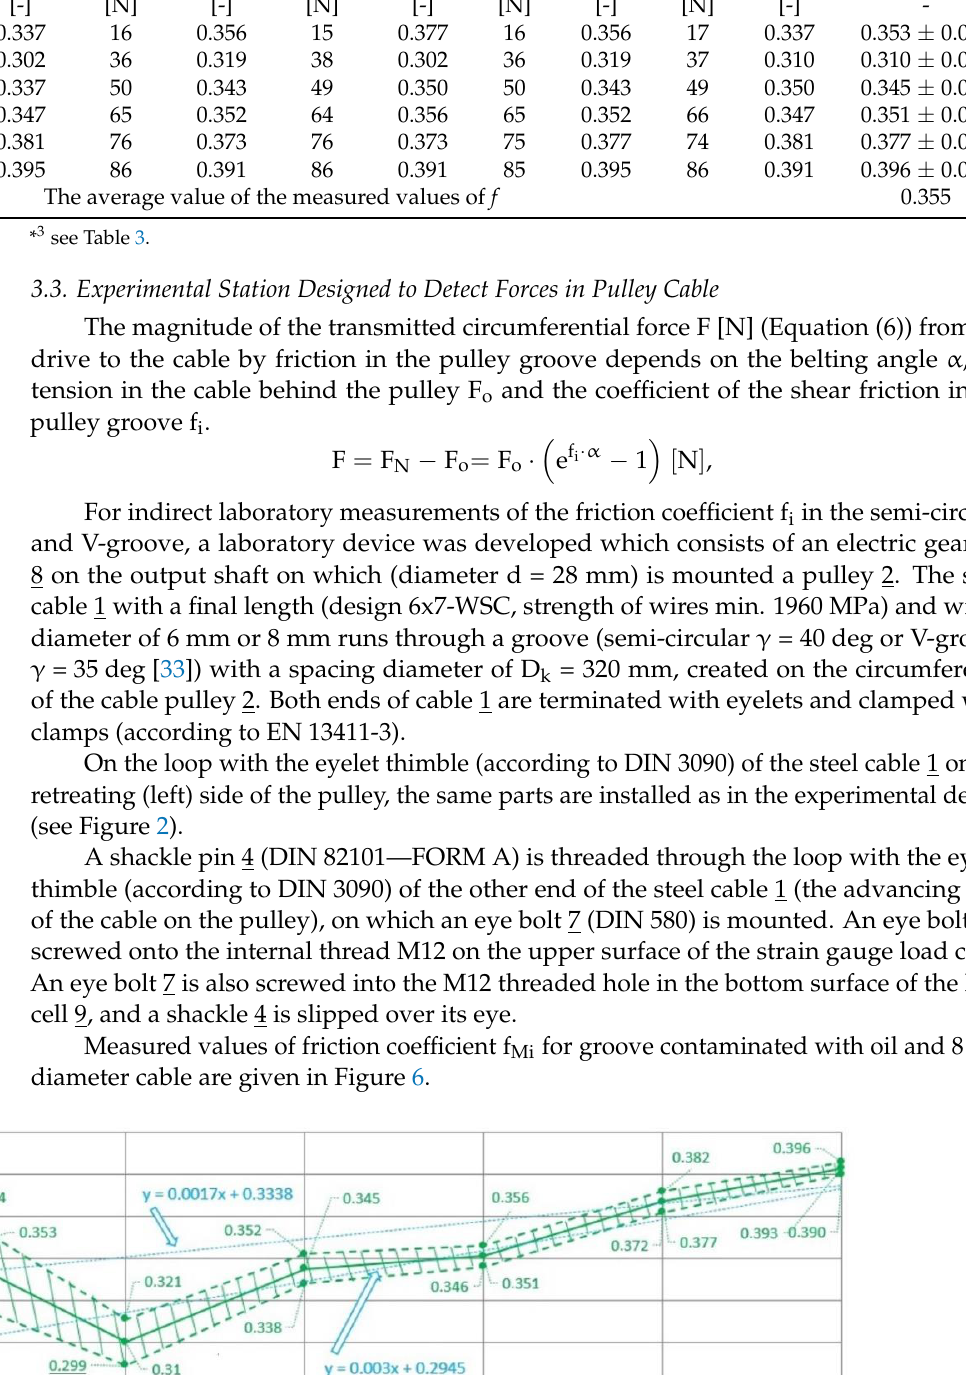
Figure 7. Laboratory equipment used to measure the pulling force on the advancing side of the cable on the pulley. On the laboratory equipment (see Figure 7) the instantaneous magnitude of the F N force is sensed by the load cell RSCC 9 [34] on the advancing side of the cable 1 on the pulley 2 under the action of the torque M 2 [N·m] on the shaft of the pulley 2, which is generated by the electro-gear transmission 8 [35]. Table 7 shows the theoretically calculated values of the pulling force F N on the ad- vancing side of the cable on the pulley according to the Euler equation for the angle γ = 40 deg of the semi-circular groove and the angle γ = 35 of the V-groove. Table 7. Pulling forces in the sides of a cable running over a pulley groove for different groove angles. m z